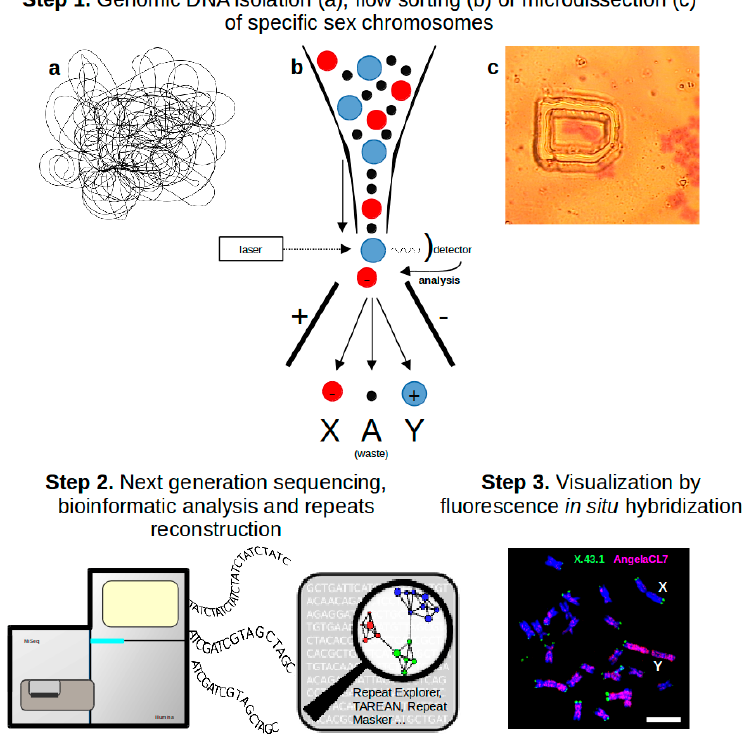
Figure 1. Typical workflow used for repeats reconstruction and characterization. Step 1—Genomic